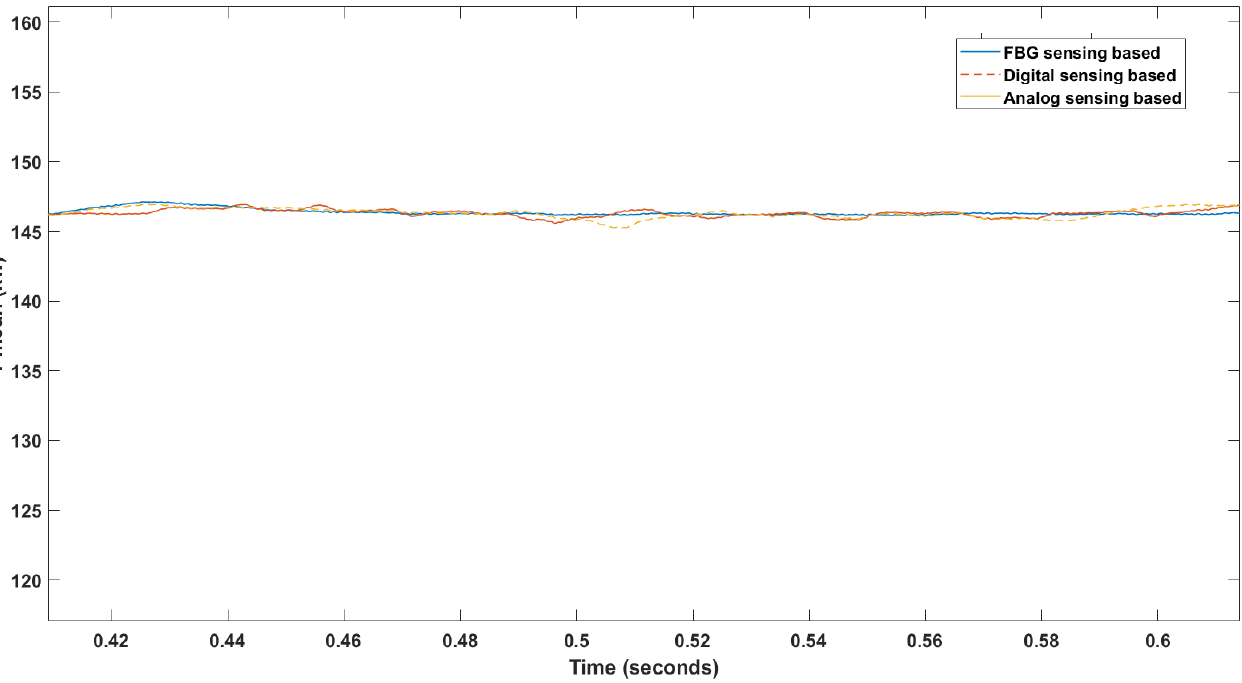
Figure 18. Output metrics at the potential point of PCC output under EMI.